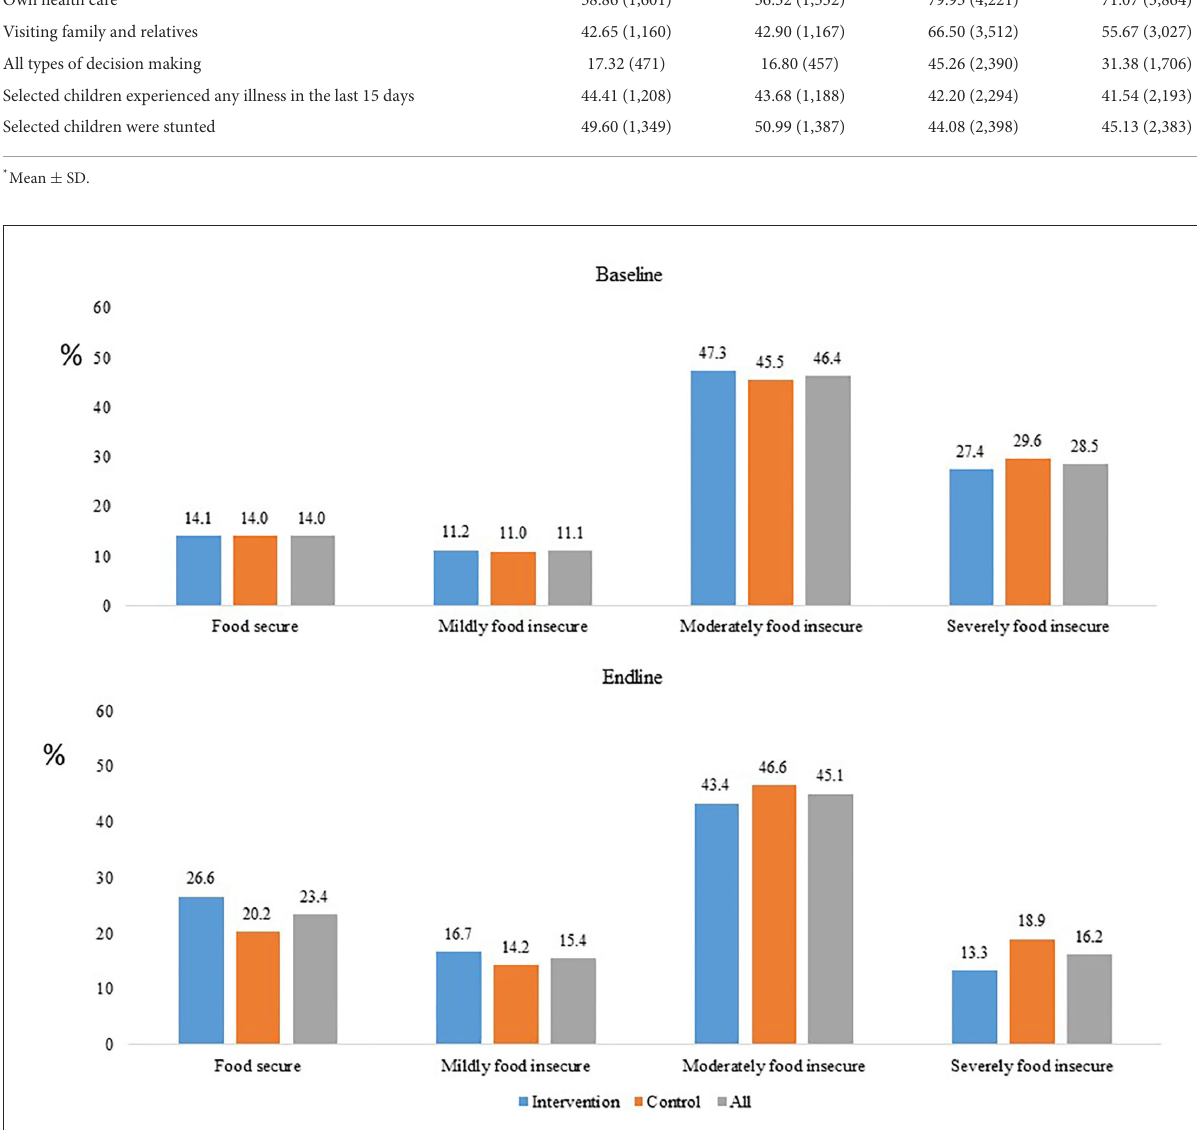
FIGURE1 Household food security status segregated by the baseline vs. endline surveys and intervention vs. control